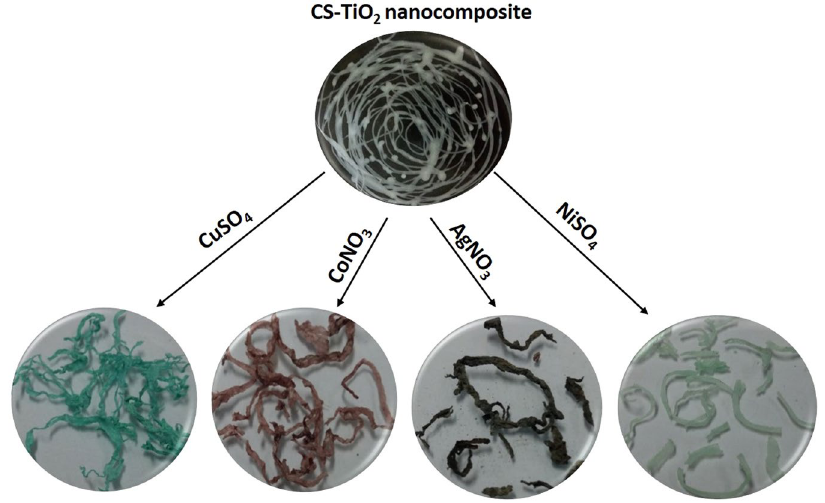
Figure 1. Pictures of pure CS-TiO 2 and treated with respective metal salt